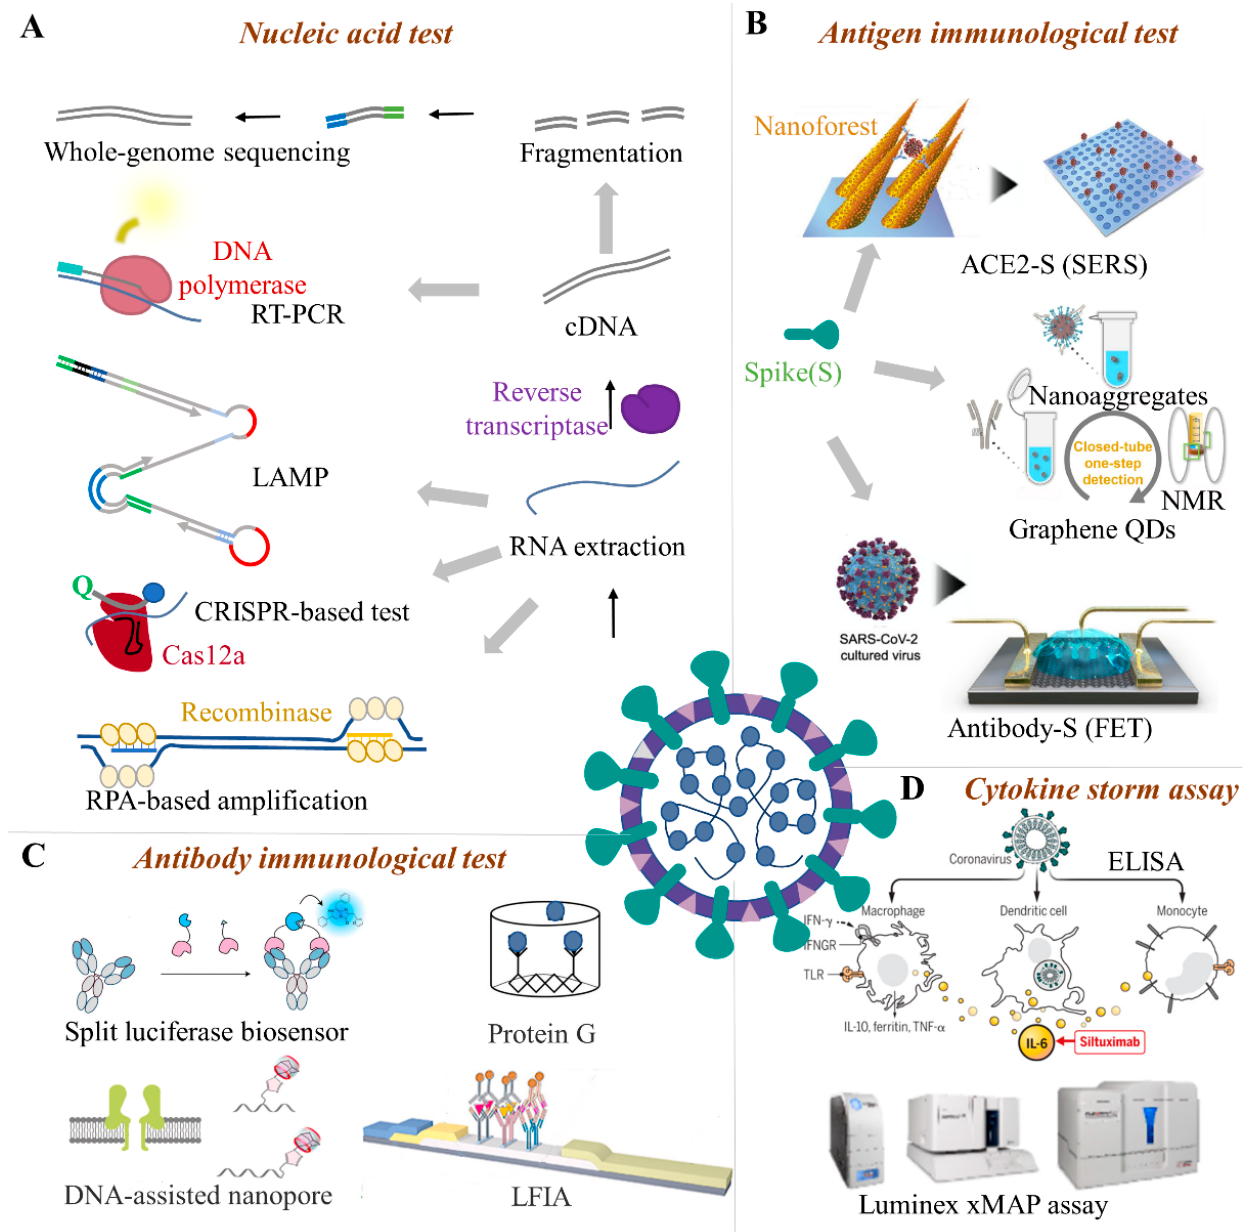
Figure 2. The advanced quarantine methods for SARS-CoV-2. For SARS-CoV-2 quarantine, many test techniques including nucleic acid and immunological methods are available. Nucleic acid tests include whole-genome sequencing and specific gene detection ( A ). Immunological tests include antigen tests ( B ), antibody immunological tests ( C ), and cytokine storm diagnoses ( D ). RT-PCR (Reverse transcription-polymerase chain reaction), LAMP (Loop-mediated isothermal amplification), CRISPR (Clustered Regularly Interspaced Short Palindromic Repeats), LFIA(Lateral-flow immunochromatographic assay), FET (Field-effect transistor), ELISA (Enzyme linked immunosorbent assay), xMAP (Multi-analyte profiling), SERS(Surface-enhanced raman